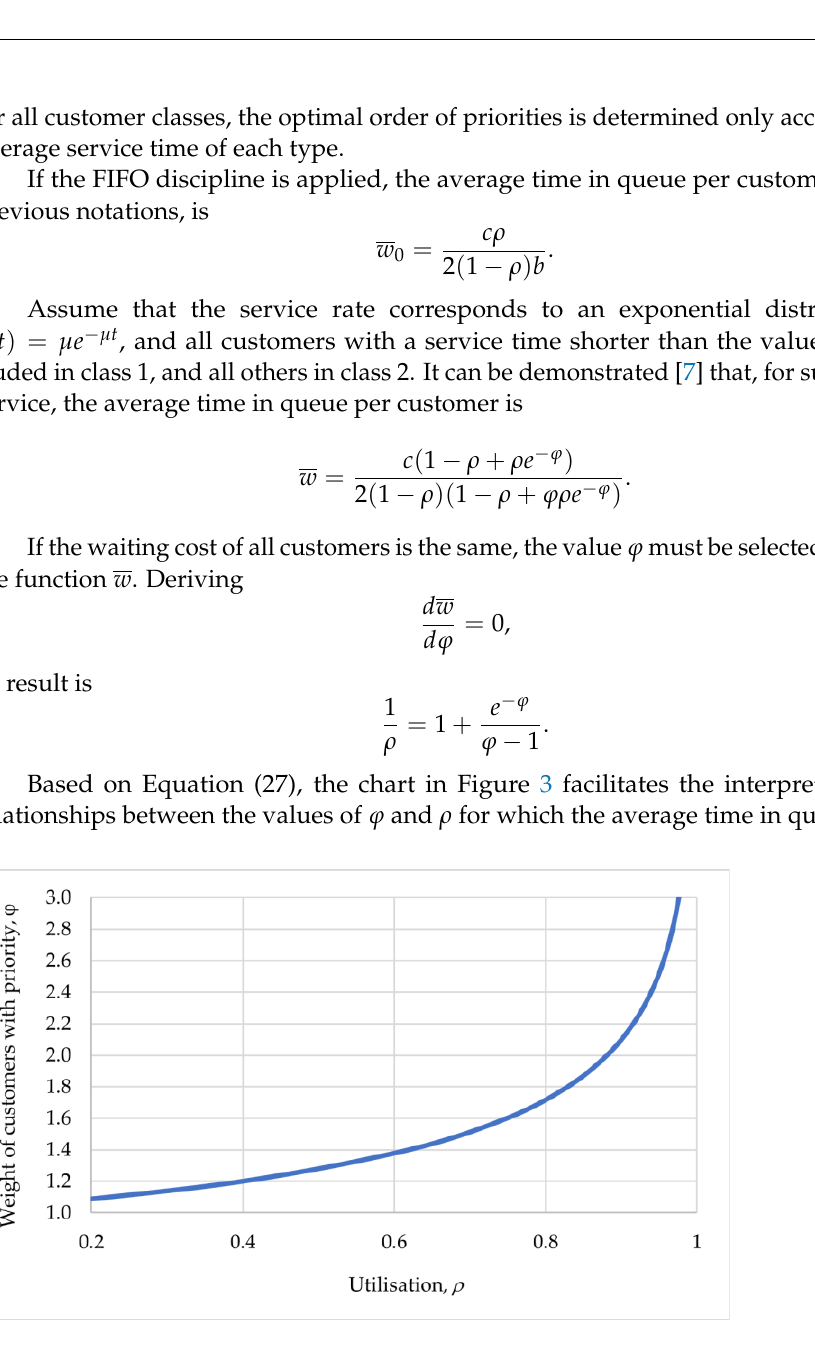
Figure 3. Relationship between service utilisation and weight of customers with priority.